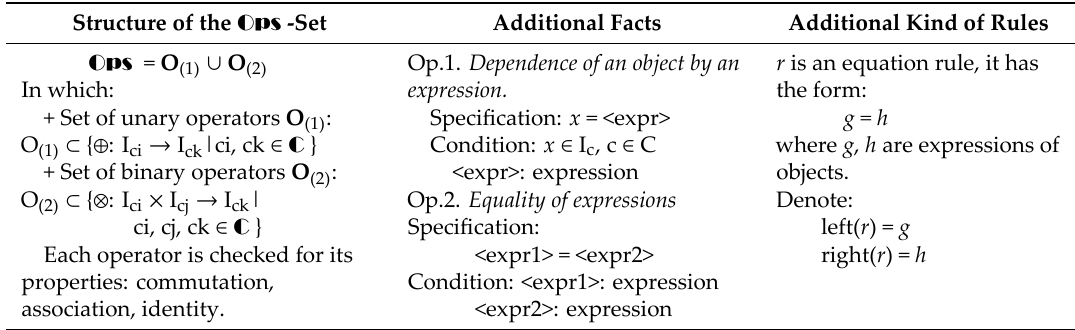
Table 2. Structure of the Ops -set.